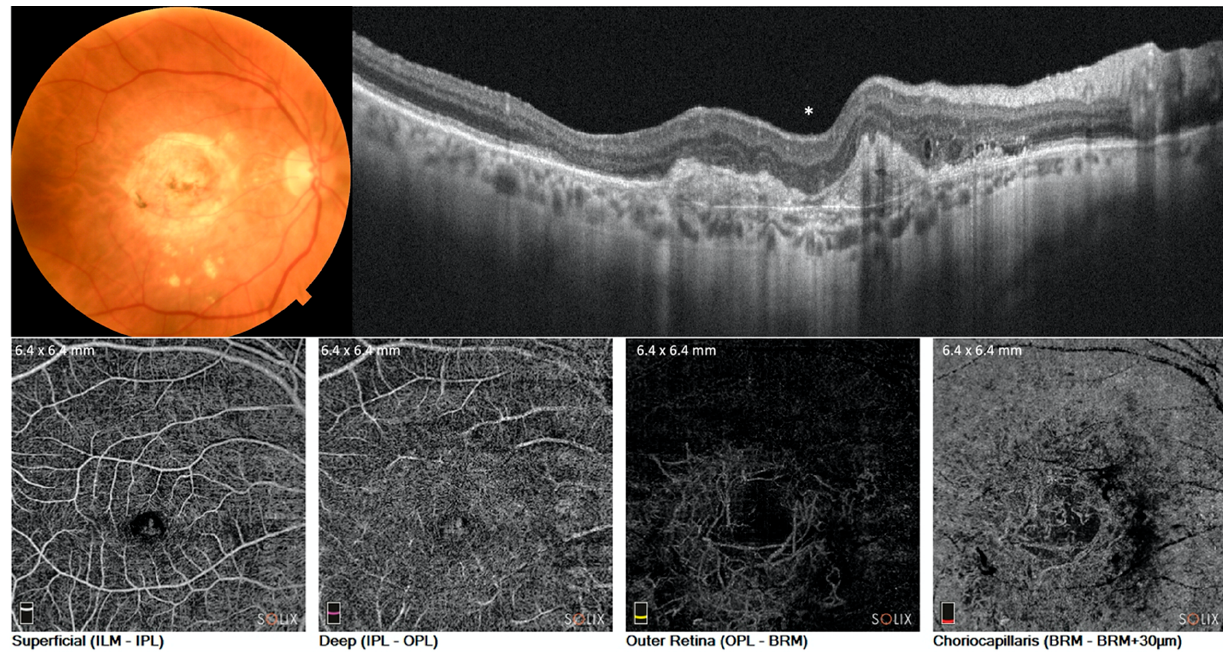
Figure 2. Advanced exudative AMD eye. Color fundus photograph ( upper and left ), shows the scar at the posterior pole. Structural B-scan ( upper and right ) revealed the hyperreflective subfoveal area below the neuroepithelium. OCT angiography of superficial and deep layers was almost preserved, while the outer and choriocapillaris showed macular neovascularization and choriocapillaris defect. * represents the fovea.